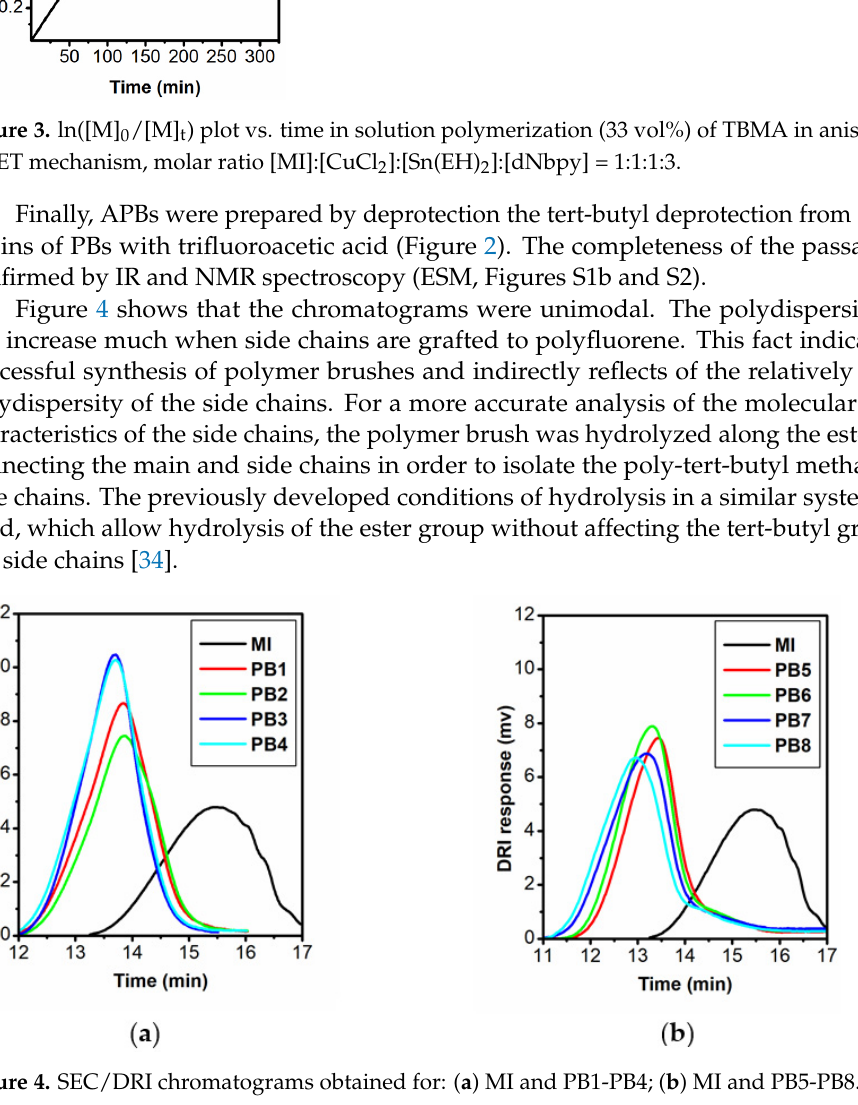
Figure 3. ln([M] 0 /[M] t ) plot vs. time in solution polymerization (33 vol%) of TBMA in anisole from